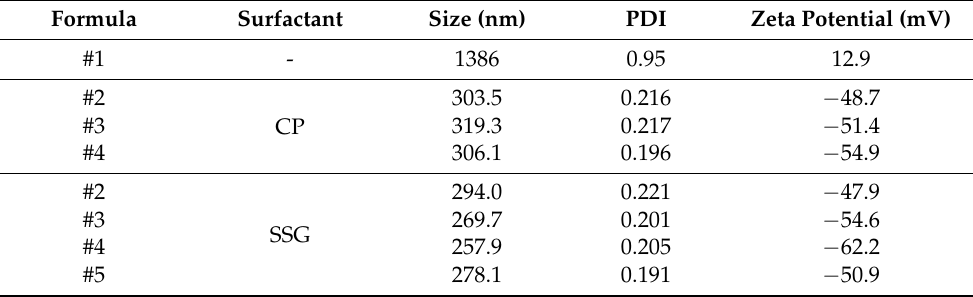
Table 3. Mean sizes, PDI values, and zeta potentials of nanostructured lipid carriers (NLC)-ROLs containing an anionic